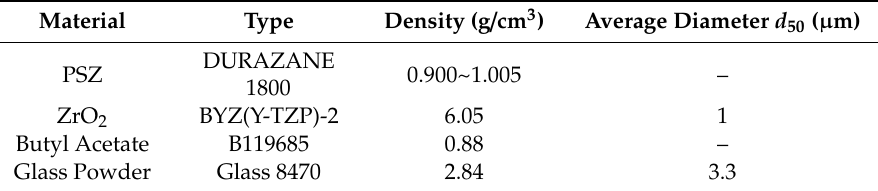
Table 1. Information on the experimental materials.